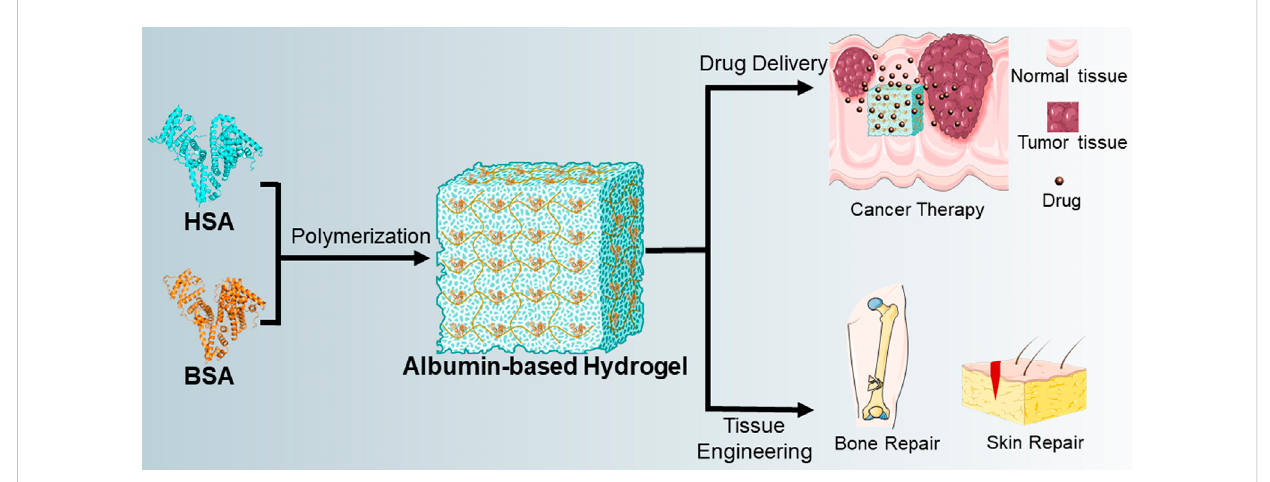
FIGURE 2 Diagram of the preparation of albumin-based hydrogels and their applications. In general, BSA is used more frequently in the preparation of albumin-based hydrogels than HSA. Two main applications for albumin-based hydrogels are drug delivery and tissue engineering, and detailed applications include the delivery of anti-tumor drugs, bone repair, skin repair,